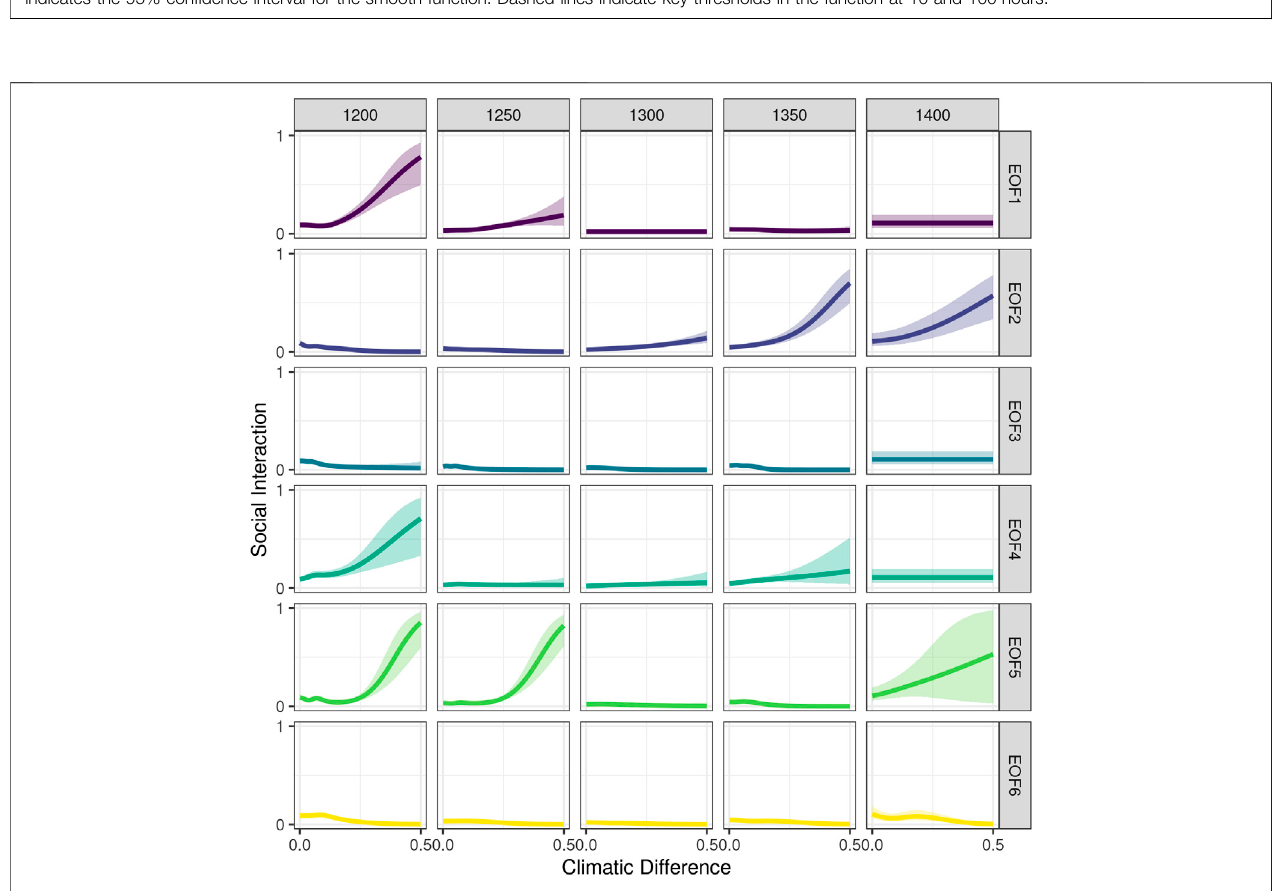
FIGURE 5 | Estimated smooth functions describing how the intensity of social interaction increases or decreases with increasing distancealongeach of six spatial drought patterns from Figure 3 , compared over fi ve time steps. As above, information fl ow is inferred from the similarity of the decorated ceramic assemblages at each pair of sites. Climatic difference is de fi ned as the absolute difference between the EOF loadings ofeach pair of sites. Shaded regions correspond to the 95% con fi dence intervals for the smooth functions.